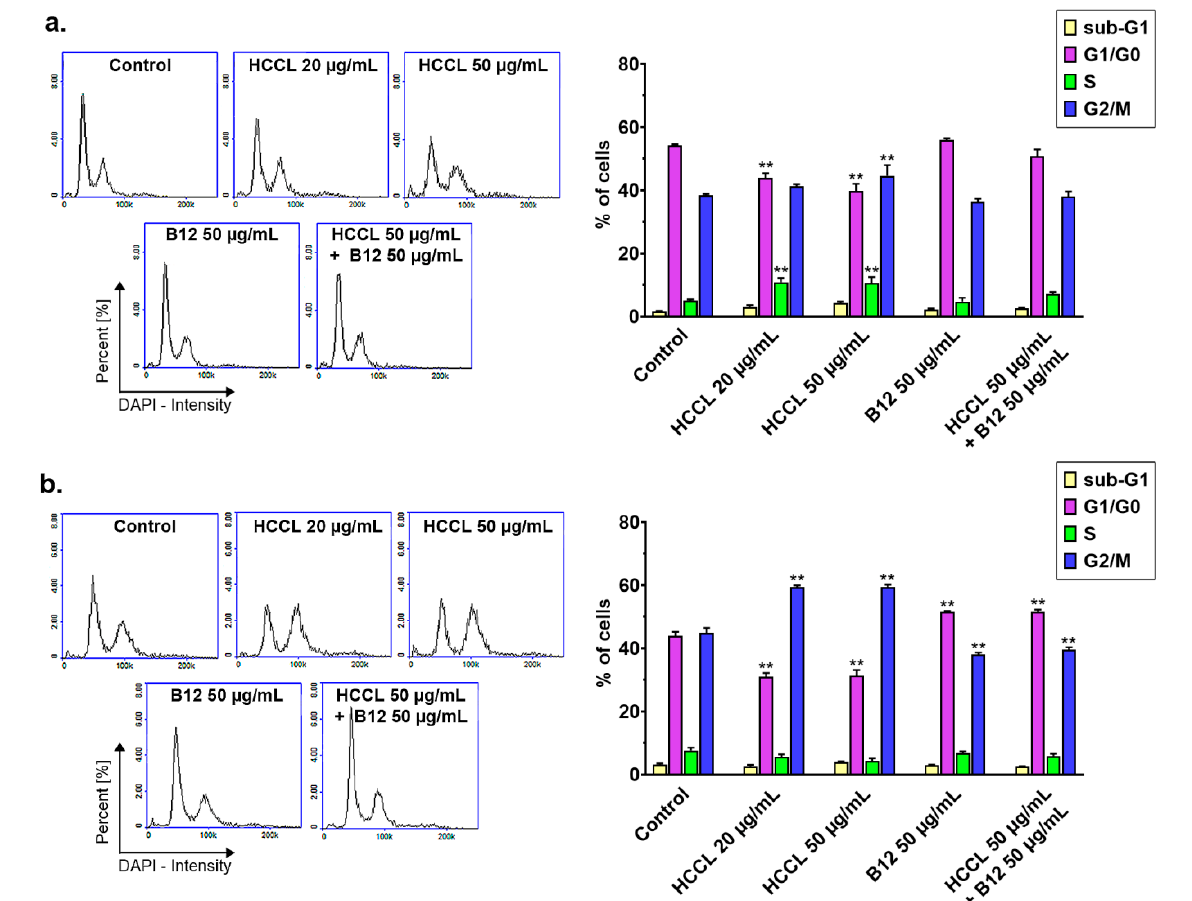
Figure 3. Cell cycle distribution of human glioblastoma cells after treatment with HCCL and/or B12. U-87 MG cells were cultured with hydroxycobalamin [ c -lactam] (HCCL) at concentrations of 20 and 50 µ g/mL or with vitamin B12 (B12) at a concentration of 50 µ g/mL or with HCCL (50 µ g/mL) in combination with B12 (50 µ g/mL). Untreated cells were cultured in parallel as a control. Representative raw histograms (left panel) and statistics (right panel) from cell cycle analysis after 9 days ( a ) or 18 days ( b ) of the treatment. Bars represent mean and SD of three independent experiments in at least triplicate; ** p < 0.01 vs. control.